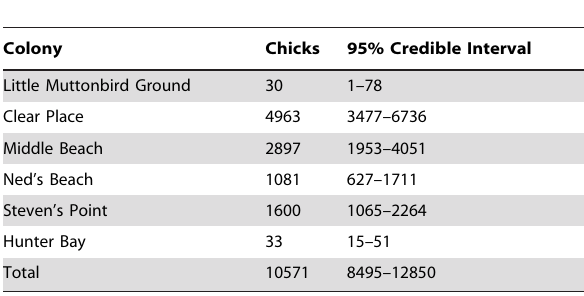
Table 2. Estimated number of chicks from each colony on Lord Howe Island, 2008–2009.